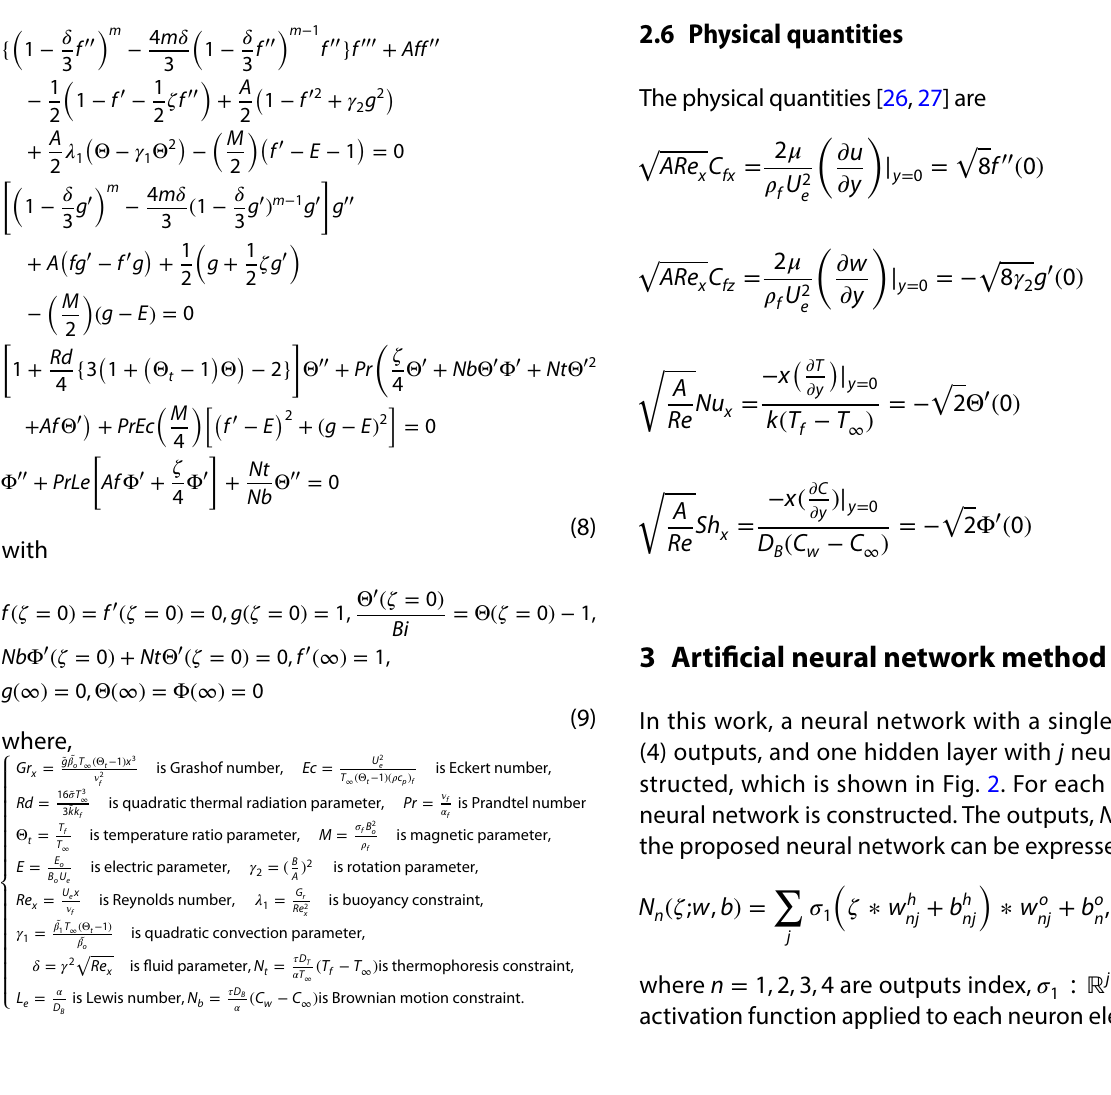
Fig. 2 A feed-forward artificial neural network